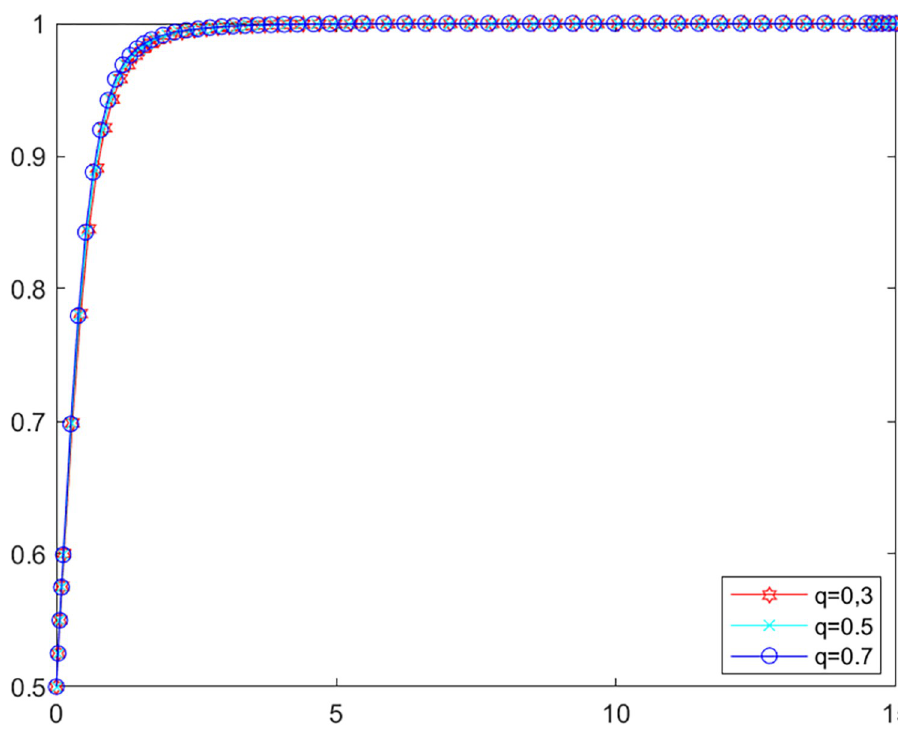
Fig 6. Government’s evolutionary path.